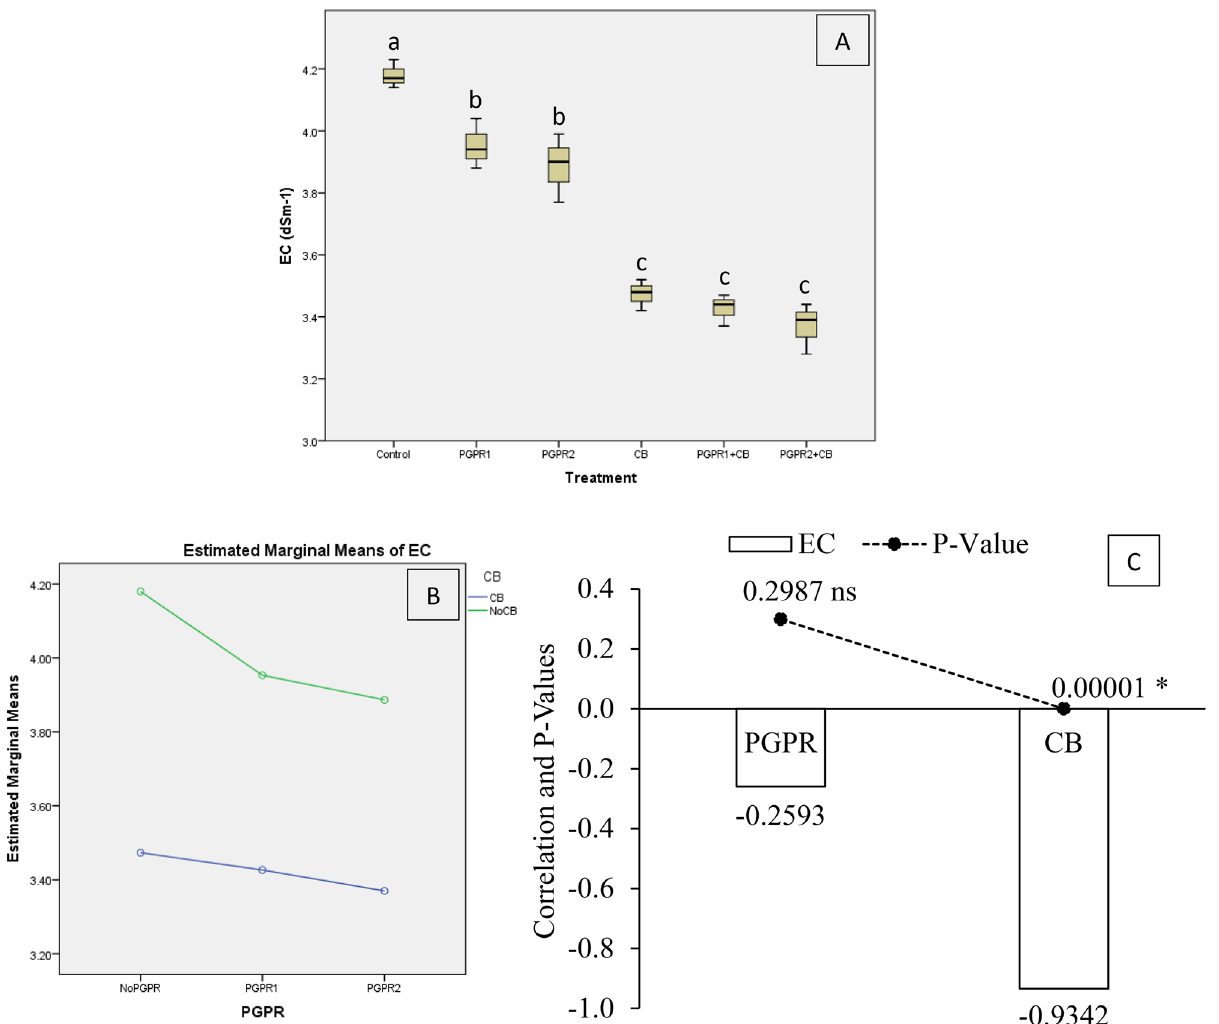
Figure 2. Effect of treatments on EC of soil. Values are the average of three replicates ( A ). Different letters showed significant differences (Tukey’s test; p ≤ 0.05). Interaction graph of PGPR and CB for soil EC ( B ). Correlation graph of PGPR and CB for soil EC ( C